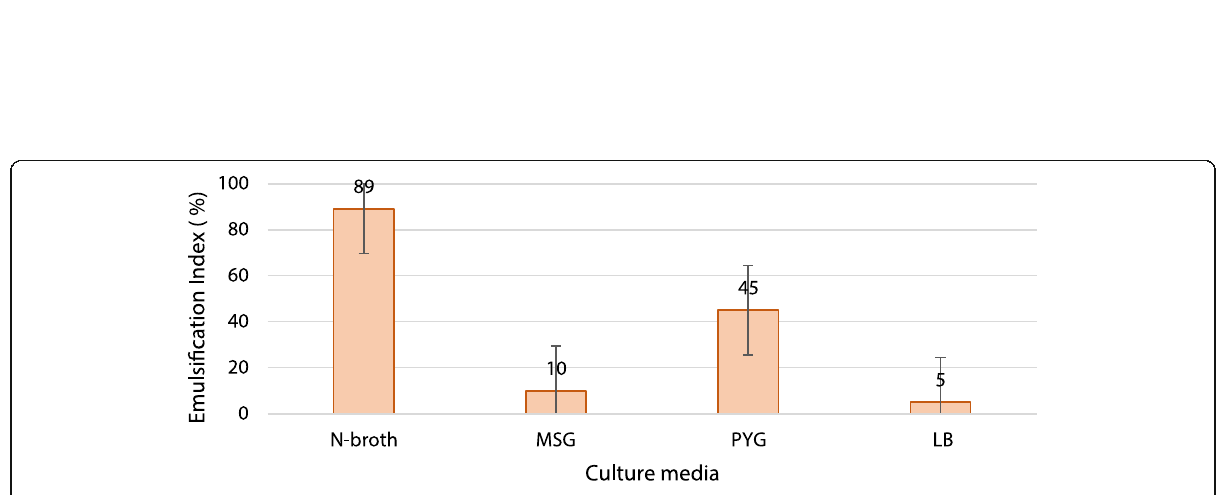
Fig. 6 Biosurfactant production by C. freundii MG812314.1 using different